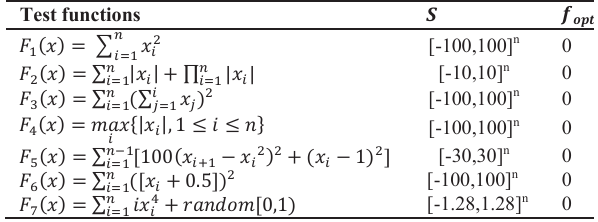
Table 1. Unimodal test